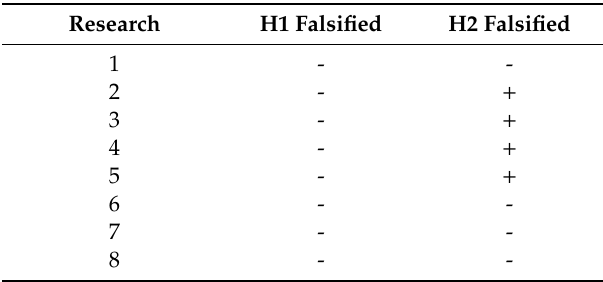
Table 3. Results of the